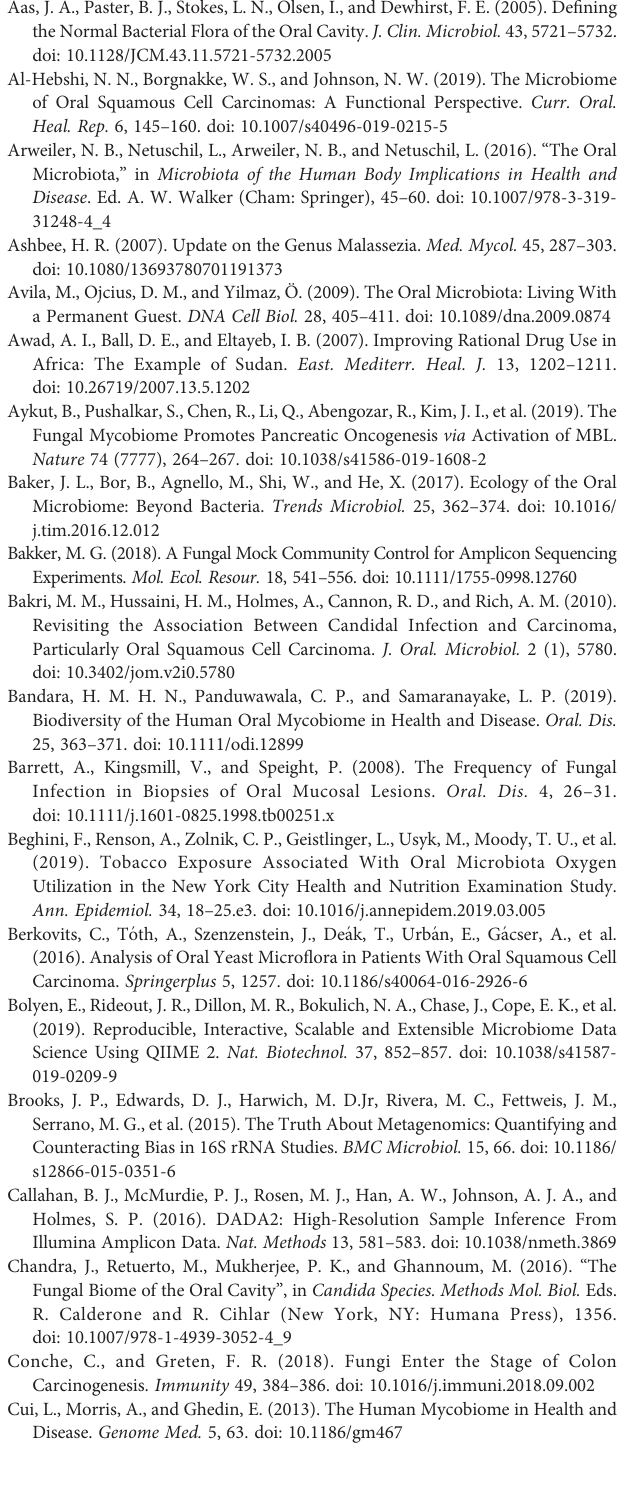
(C) Distribution and differences in abundance of 5 topmost salivary fungi according to OralHygiene Index (Simpli fi ed). (D) Distribution anddifferences in abundanceof 5 topmost salivary fungi according to mean number of decayed teeth. (E) Distribution